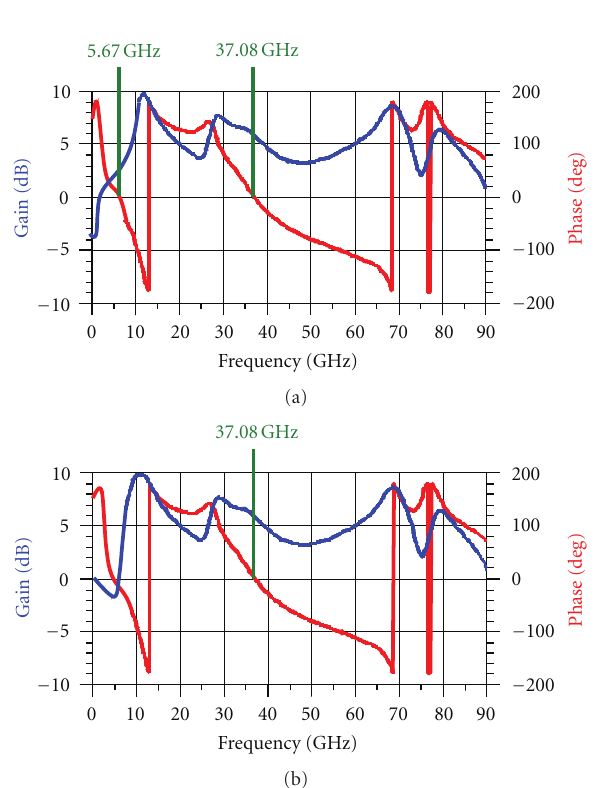
Figure 16: The open loop operation.